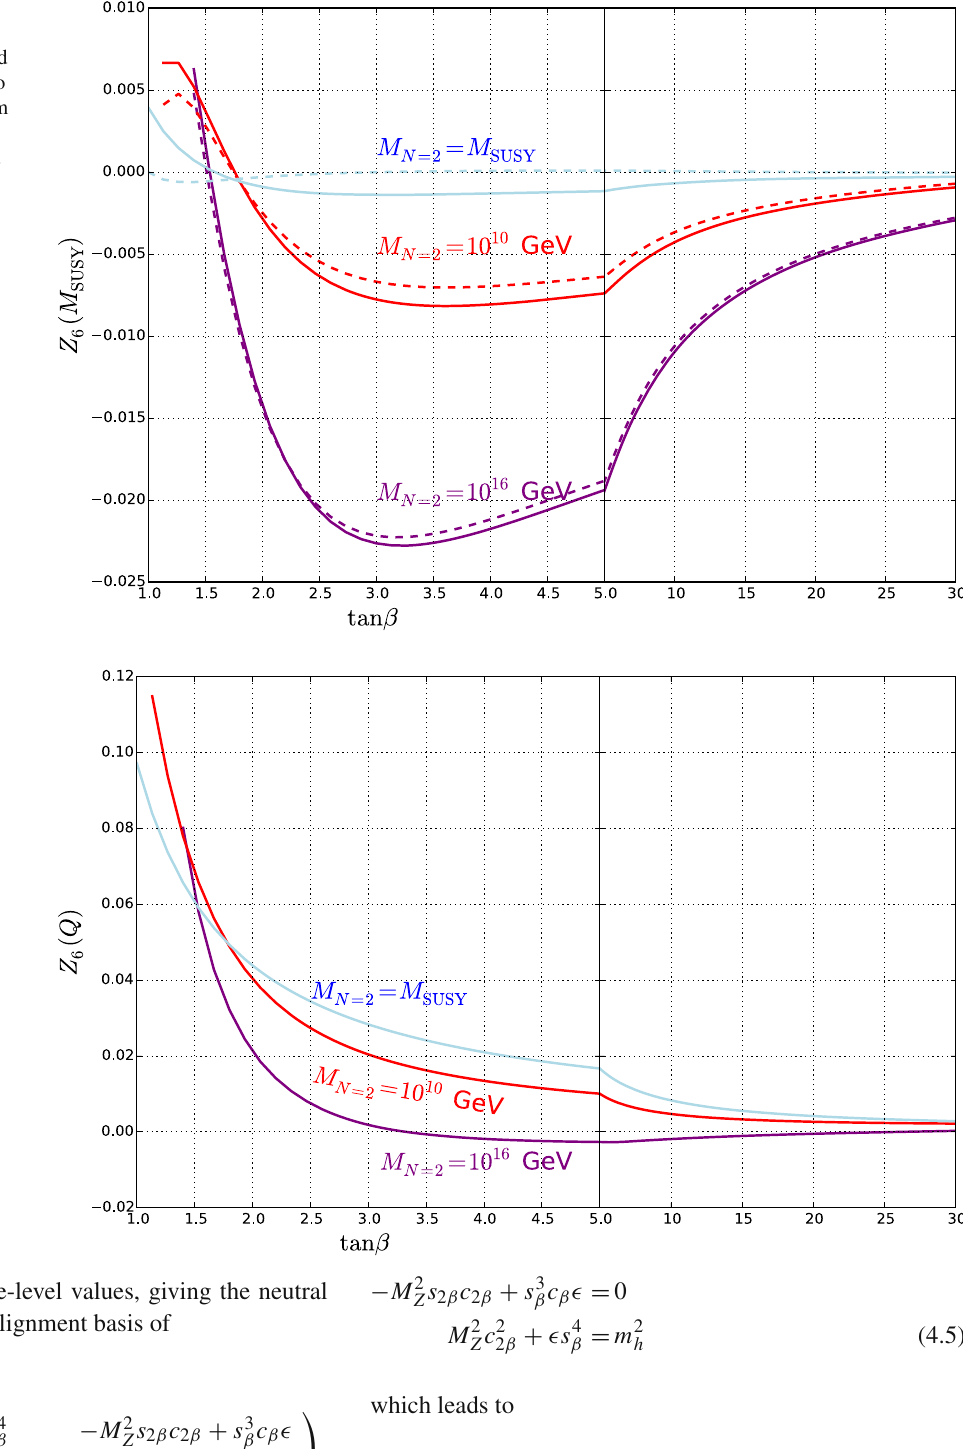
Fig. 3 Z 6 ( M SUSY ) against tan β for M N = 2 = M SUSY , 10 10 GeV and 10 16 GeV, which corresponds to just the contributions to Z 6 from the running of λ S , T and the threshold corrections. The solid lines show the full value of Z 6 , while the dashed lines are just those given by Eq. (4.3), i.e.